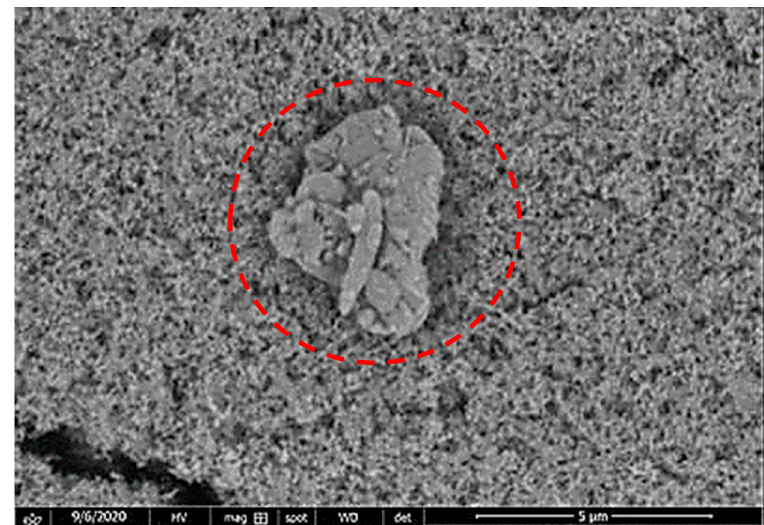
Figure 17. SEM micro ‐ image of dust residues within micro ‐ post spacing. The red circle shows dust particles. Table 2. Variation of ratio of dust removed area with We number for 10 µ L